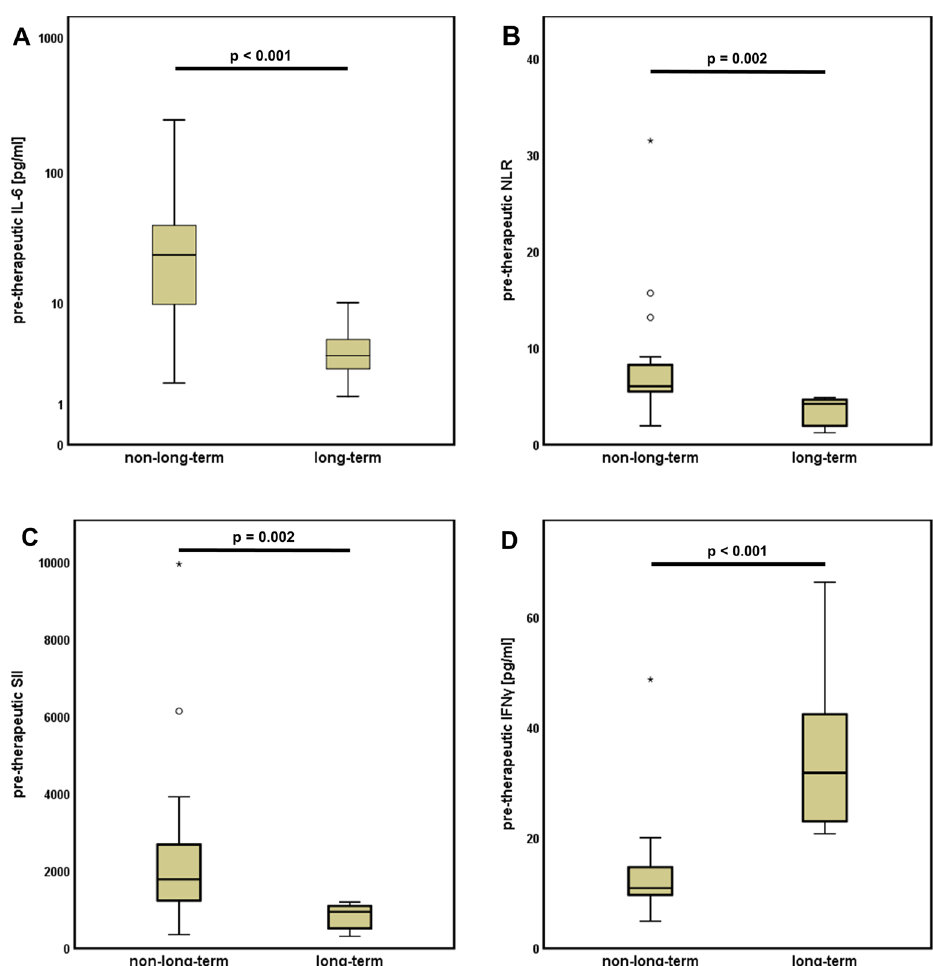
Figure 3. Pre-therapeutic inflammatory scores and cytokine levels predict long-term response to ICI. Patients with long-term response showed significantly lower levels of ( A ) interleukin 6 (IL-6), ( B ) neutrophil to lymphocyte ratio (NLR) and ( C ) systemic inflammation index (SII) or elevated levels of ( D ) interferon gamma